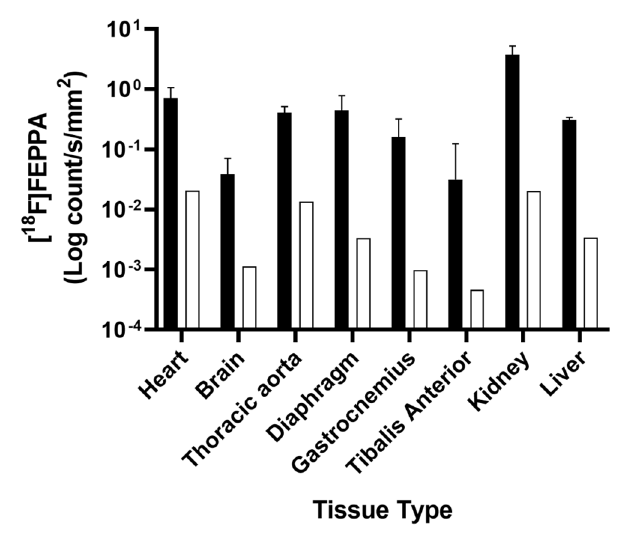
Figure A3. Quantified autoradiography of [ 18 F]FEPPA activity in MDX and wild-type mice. Data ( ± SE) depicts the log counts per second per millimetre squared area of [ 18 F]FEPPA activity within slices of heart, brain, thoracic aorta, diaphragm, skeletal muscles, kidney and liver for MDX (black bars; n = 3 mice) and an age-matched wild-type control (white bars; n = 1 mouse). No statistical analyses were conducted due to low sample sizes. MDX = dystrophin-deficient mdx:utrn (+/−) mouse models.